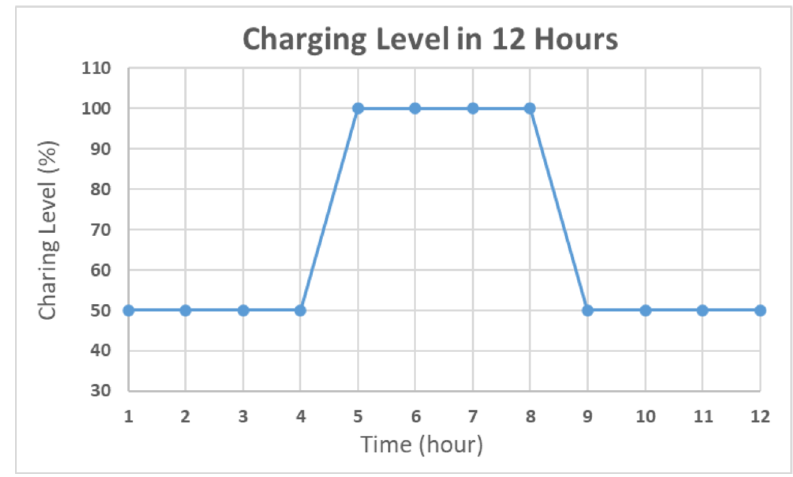
Figure 5. Charging level distribution over 12 h.